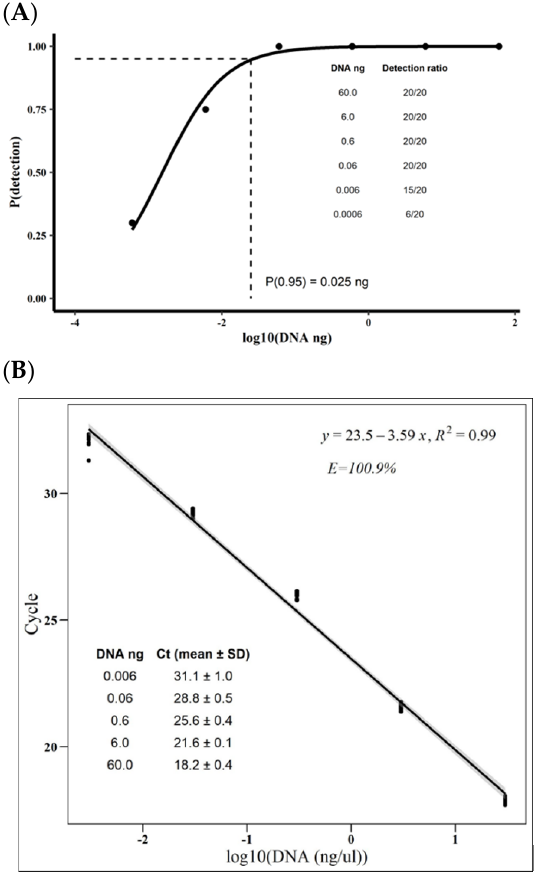
Figure 1. Limit of detection (LOD) and efficiency of the Moniliophthora roreri qPCR. Then, 2 µ L of serial dilutions ( × 1/10n) of the DNA extracted from the mycelia of M. roreri strain MR2 with concentrations between 30 and 0.0003 ng per µ L were evaluated in two separated qPCR, each containing ten technical replicates per dilution. Non-template (H 2 O) and negative ( M. perniciosa basidiocarp DNA) controls were included in every qPCR. ( A ) shows the correlation between the probability of detecting the M. roreri DNA (i.e., return a positive qPCR) and the log10 of DNA amount in the serial dilutions (between 60 and 0.0006 ng). The points represent the probability of the M. roreri DNA dilutions to return a positive qPCR, defined as a qPCR reaction with a Ct below 30. The solid line represents the prediction of the general linearize model (GLM) with the logit function and the binomial family error (Table S4). The dashed line represents the qPCR’s 95% detection limit. ( B ) shows the correlation between the qPCR threshold cycle (Ct) and the logarithm with base 10 (log10) of the DNA concentration of the M. roreri serial dilutions. The points (n = 20 per log10 of DNA concentration) represent each sample. The line and the gray area represent the prediction and standard error of the linear model (lm), respectively.